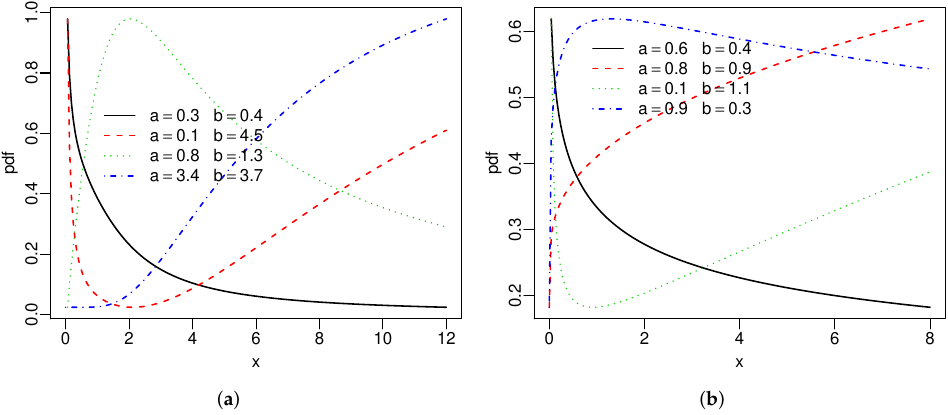
Figure 2. Special hrfs: ( a ) SBXII ( a , b ,1.9,0.4,2.2 ) and ( b ) SW ( a , b ,0.7,1.5 )